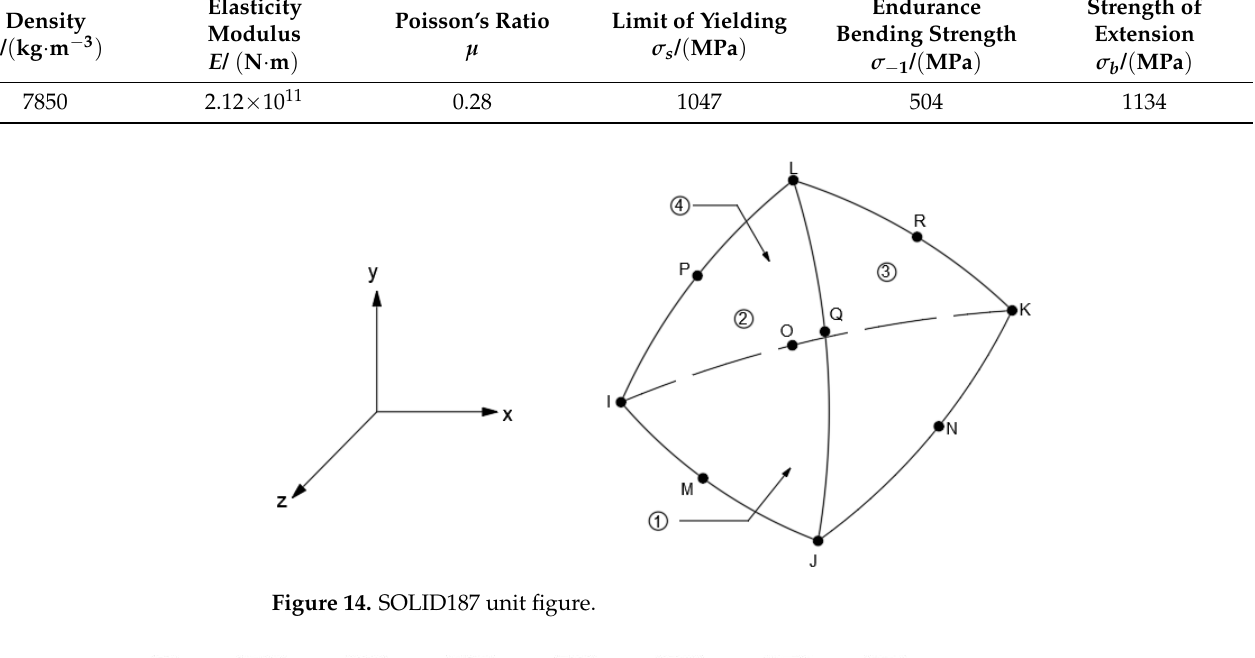
Figure 14. SOLID187 unit figure. Table 2. Performance indicators of 42CrMo.